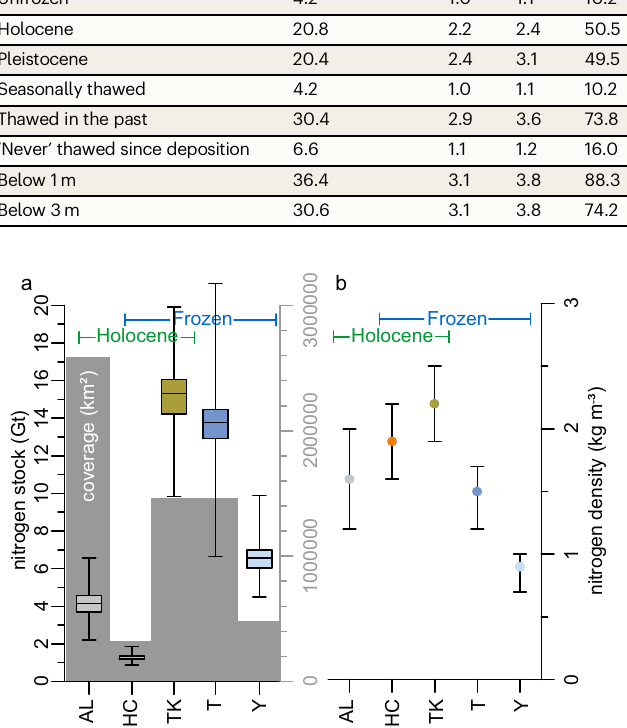
Fig. 3 | Assessment of N stocks of the Yedoma domain, subdivided into fi ve stratigraphicunits.a Nstockboxplotswithmin-maxrangesandarealcoverageof each unit (grey vertical bars) in km²). b N density in kgNm − 3 . See Fig. 1 for the abbreviations of the stratigraphical classes.